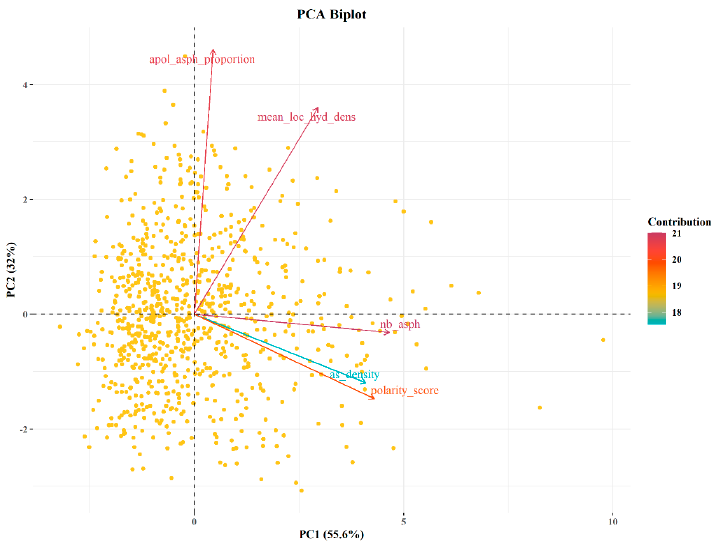
Figure 4. Principal components analysis (PCA) of the physico-chemical properties used to calculate the druggability score with Fpocket.